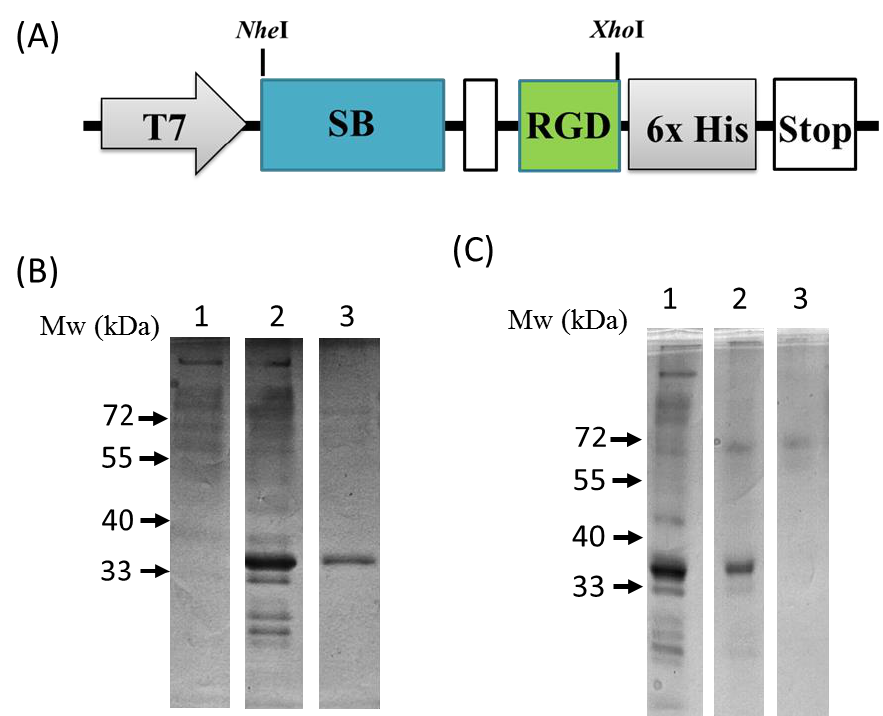
Figure 2. ( A ) Schematic representation of the cloning site for genetic engineering of the fusion protein SB-RGD. ( B ) The SDS-PAGE result of the expressed and purified fusion proteins. Lane 1: pre-induced whole-cell lysate (negative control); lane 2: soluble fractions (crude proteins) of induced SB-RGD; lane 3: the purified SB-RGD protein. ( C ) The SDS-PAGE result of the SB-RGD dissociation assay. Lane 1: the induced whole-cell lysate; lane 2: the silica particles immersed in the induced whole-cell lysate, washed by incubation with 25 mM Tris buffer (pH 8.0) containing 2 M NaCl for 30 min, and finally boiled at 95 ° C for 15 min with SDS sample buffer before being loaded into SDS-PAGE for analysis. Lane 3: sample treated exactly the same as lane 2 except that the wash was conducted with 25 mM Tris buffer (pH 8.0) containing 2 M MgCl 2